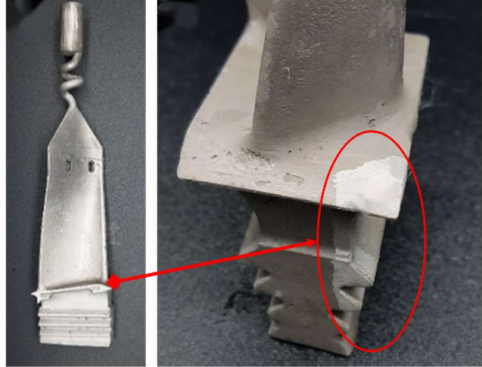
Figure 1. Stray grains at the